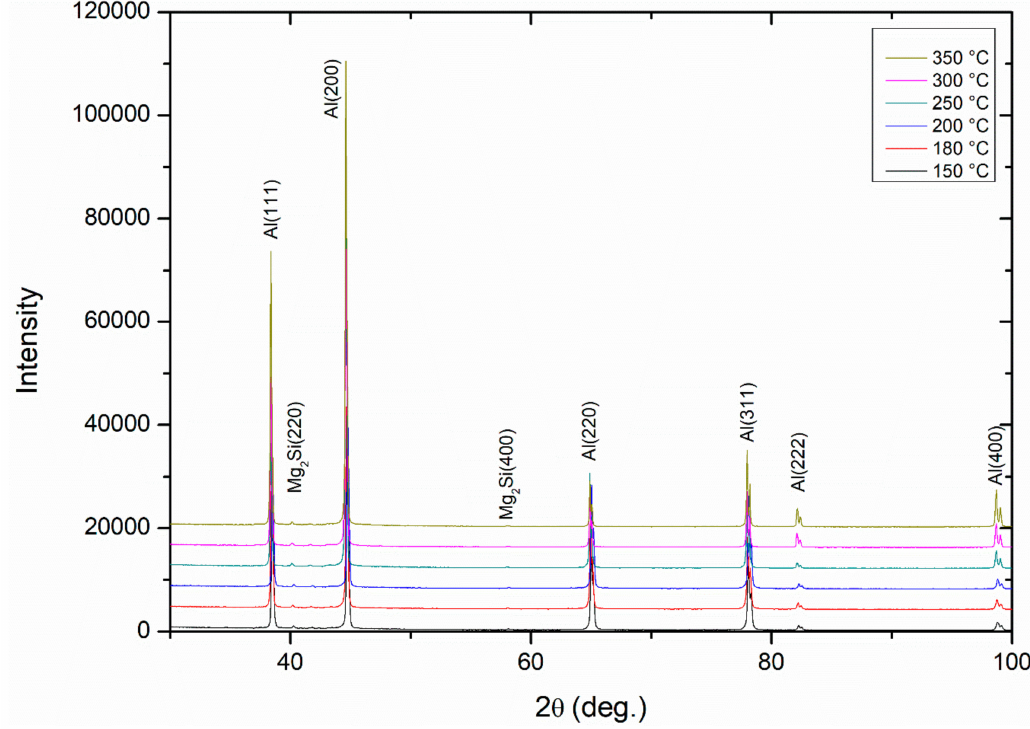
Figure 9. X-Ray di ff raction profiles of DRECE processed and annealed 5754 aluminum